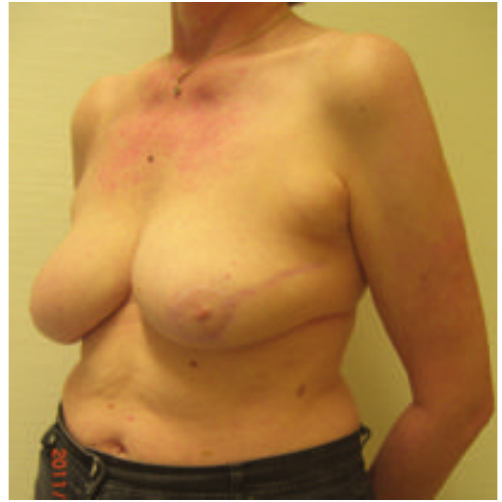
Figure 10: Same patient at 18-month follow-up, oblique view.